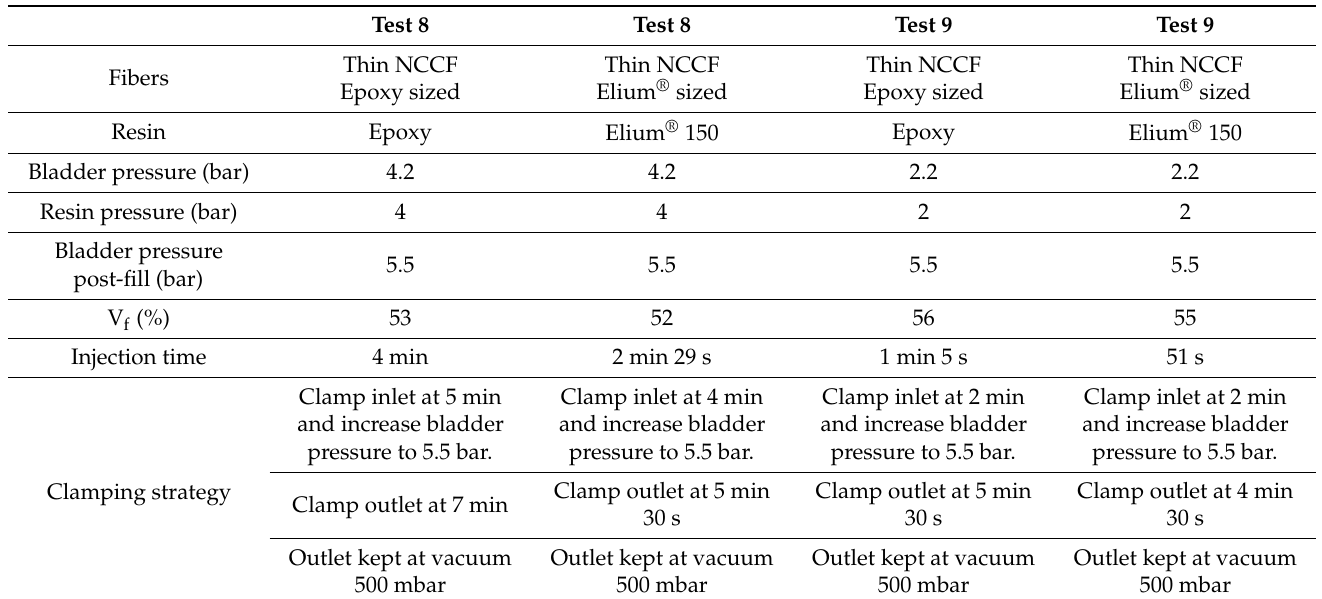
Figure 15. Tubular section showing better-filled corners with a larger preform. Table 5. Injection results during B-RTM process with reduced bladder and injection